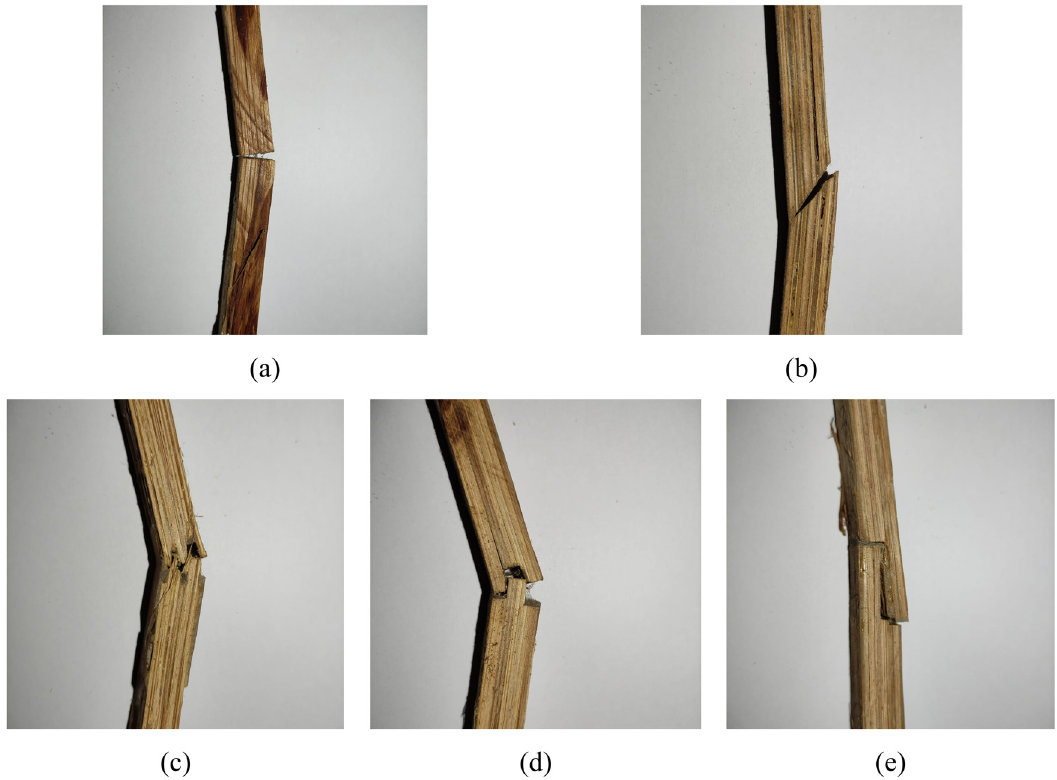
Figure 13: Macrography of bending test specimens: ( a ) butt joint, ( b ) scarf joint, ( c ) fi nger joint, ( d ) tongue and groove joint, and ( e ) desk joint.